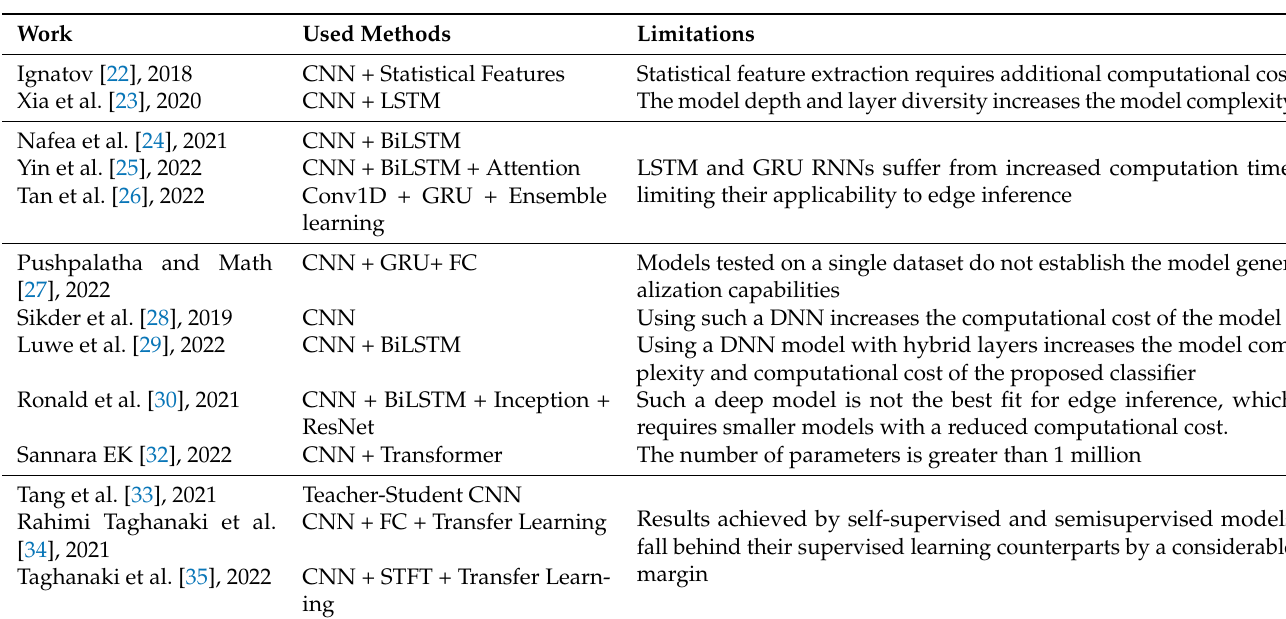
Table 1. Summary of HAR-related work presented in this